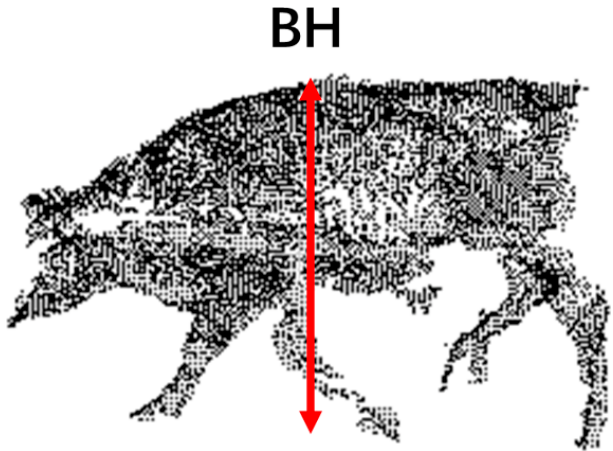
Figure 20. Reduction in wither height caused by leg crossover.